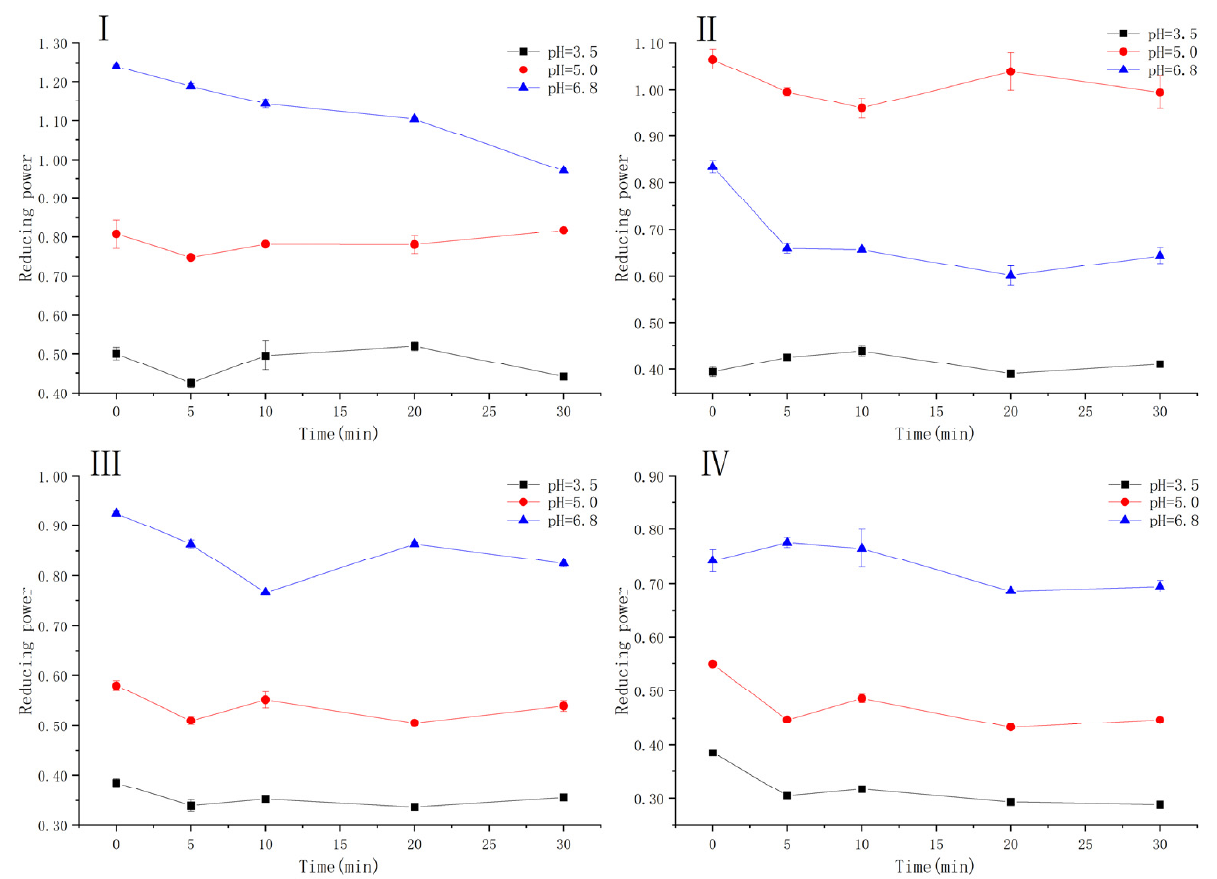
Figure 4. The reducing power of enzymatic browning products of ( I ) Catechin ( II ) Epicatechin ( III ) Caffeic acid ( IV ) Chlorogenic acid in various values of pH.